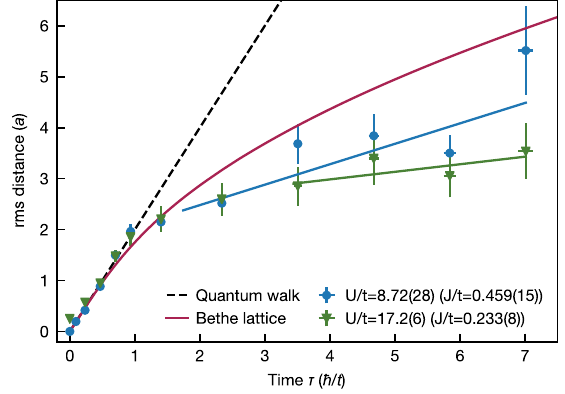
FIG. 3. Long-time slowdown of the hole propagation due to superexchange. Root-mean-squared distance from the origin, obtained from a Gaussian fit to the 2D hole density distribution. The initial linear increase indicates a ballistic expansion com- patible with a noninteracting quantum walk (dashed black line). The hole slows down around τ ¼ 1 ℏ =t , an effect qualitatively predicted by an analytic model based on a free quantum walk in a Bethe lattice (solid blue line). At later times, the hole is more confined than the Bethe-lattice prediction. Increasing the inter- action energy decreases the superexchange and the long-time hole velocity, from 0 . 40 ð 10 Þ a= ð ℏ =t Þ at U=t ¼ 8 . 72 ð 28 Þ to 0 . 15 ð 17 Þ a= ð ℏ =t Þ at U=t ¼ 17 . 2 ð 6 Þ as obtained from linear fits at τ ≥ 0 . 8 ℏ =J .